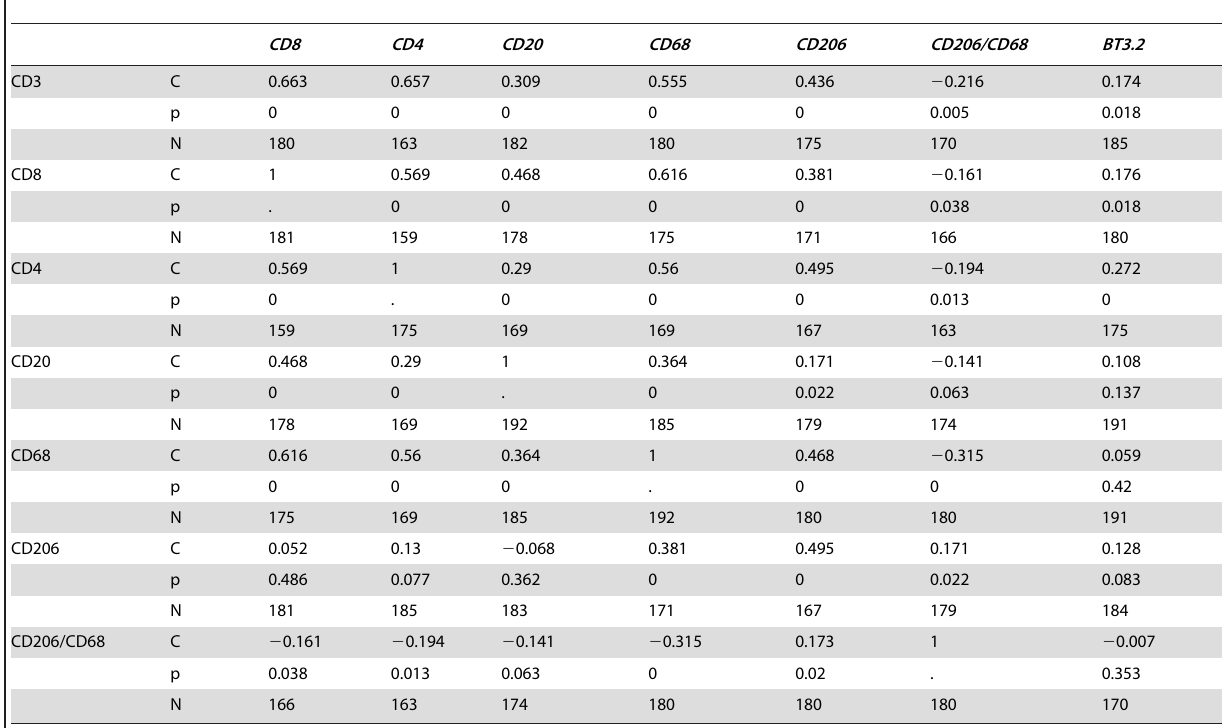
Table showing the Pearson coefficient of correlation C between staining observed for each marker in the intra-epithelial ovarian tumor tissues. Grade and stage were evaluated according to the FIGO classification. P is the p value from Pearson correlation test. N is the number of cases included in the statistical analysis for which the observed staining was reliable. CD206/CD68= ratio of CD206 + /CD68 + staining in the intra-epithelial area of tumor. C= Pearson correlation coefficient. P=p value.